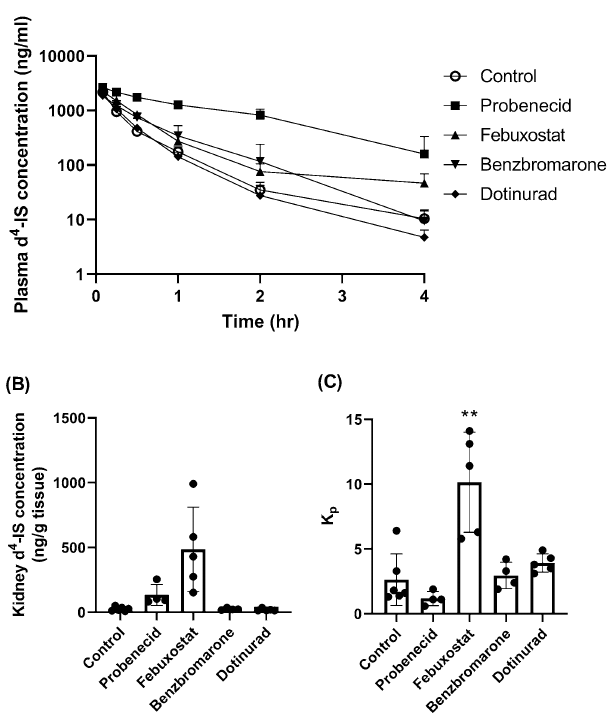
Figure 2. Effect of hypouricemic agents on d 4 -IS concentration in the plasma ( A ) and kidney ( B ), and K p ( C ) in intact rats. IS: indoxyl sulfate, K p : kidney-to-plasma partition coefficient. Hypouricemic agents or their vehicles as controls were orally administered to Wistar rats fasted for 16 h. After 30 min, d 4 -IS was intravenously administered. Blood samples were collected at 0.083, 0.25, 0.5, 1, 2, and 4 h after d 4 -IS administration. Plasma samples were deproteinated, and the d 4 -IS concentration was measured by LC–MS/MS. Each value is presented as mean + SD ( A ) or mean ± SD with individual dots ( B and C ) of four to six animals. ** P < 0.01, significantly different from the control group according to Dunnett’s multiple comparison test.